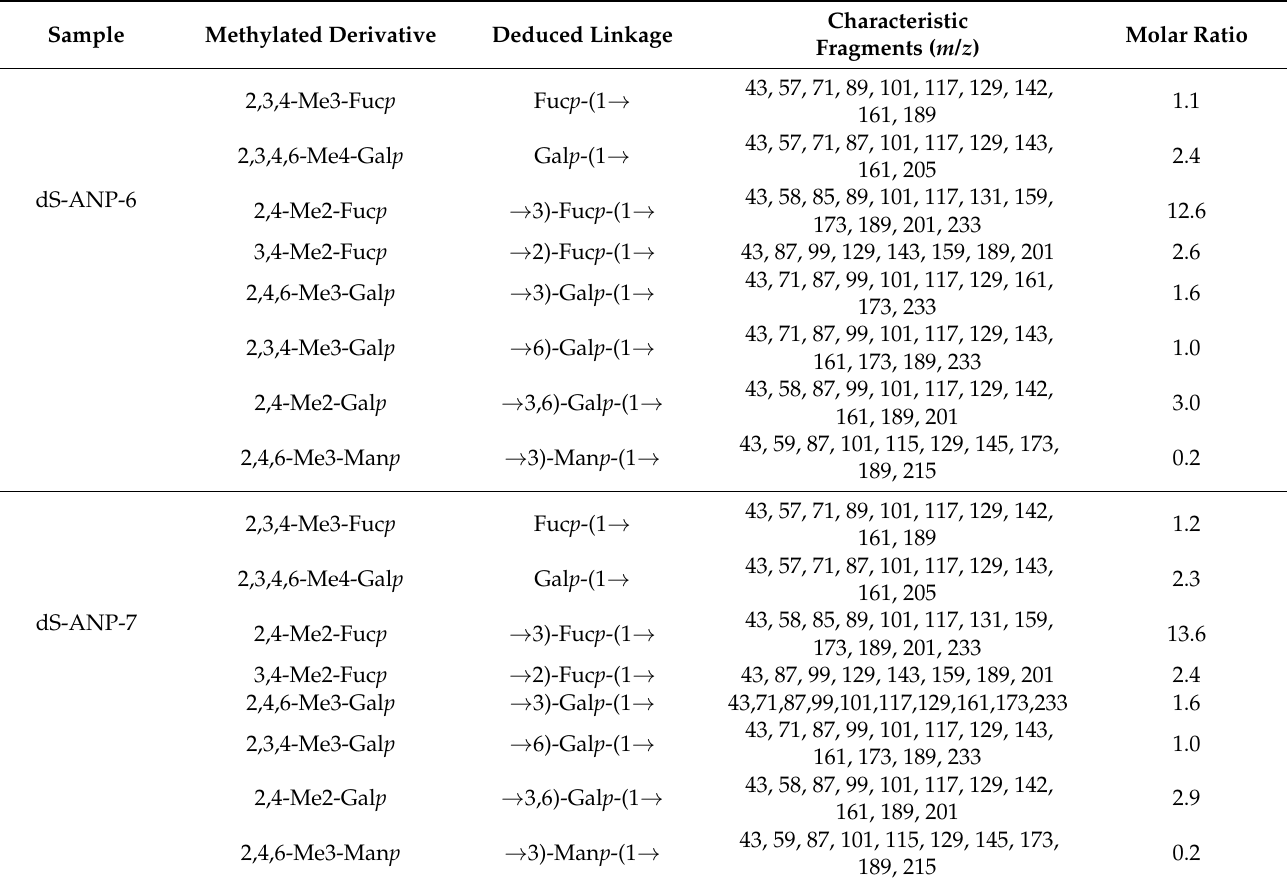
Table 2. Methylation analysis and mode of linkage of dS-ANP-6 and